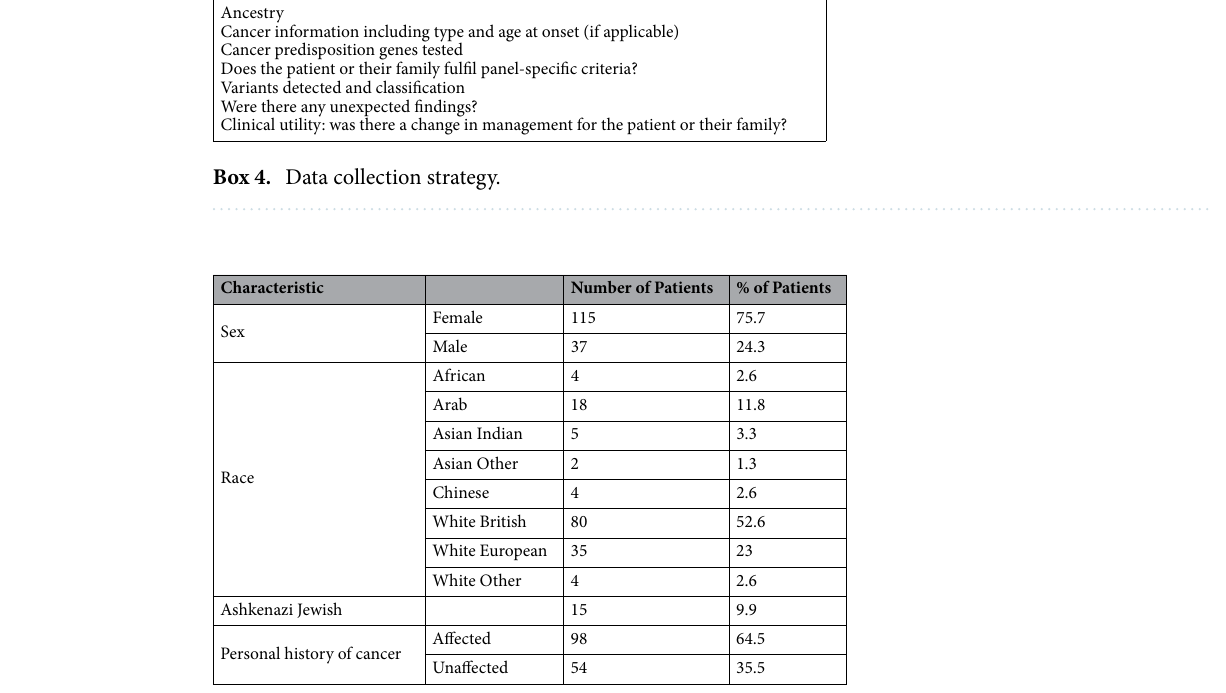
Table 2. Characteristics of study